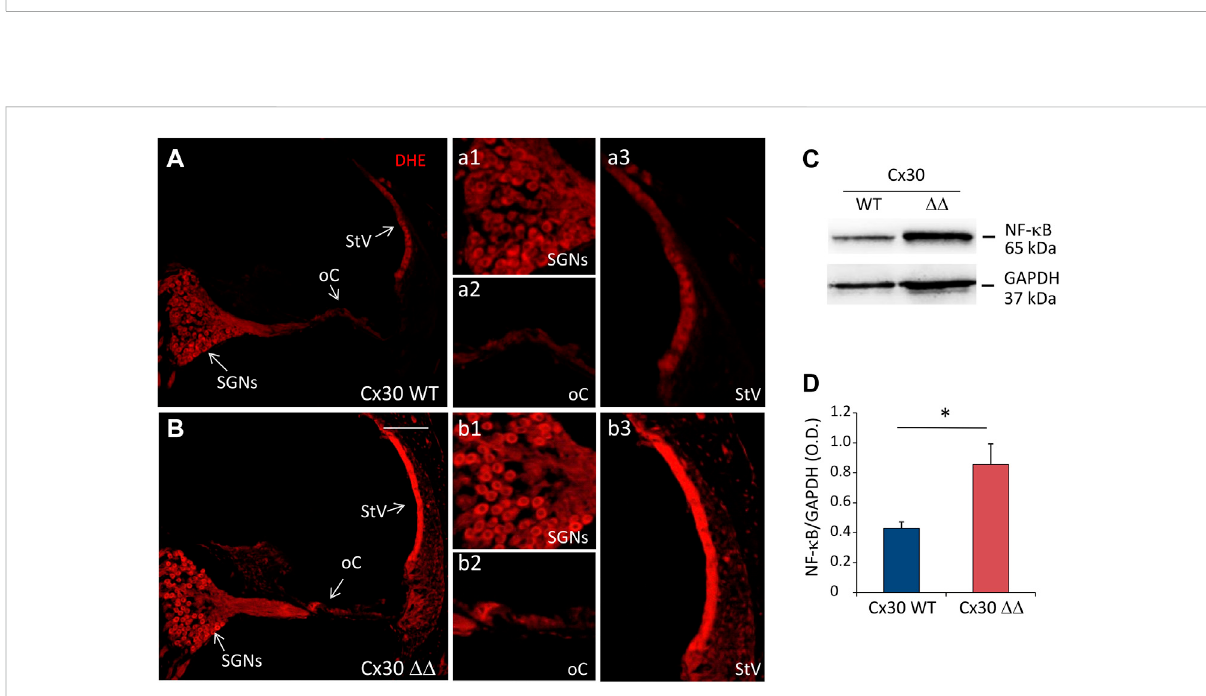
FIGURE 4 Increased oxidative stress and in fl ammation in the cochlea of Cx30 ΔΔ mice of 12 months of age. (A and B) : Representative images of cochlear cryosectionsfromCx30WT (A) andCx30 ΔΔ (B) miceof12monthsofagestainedwithDHEtoanalyzetheROSamount.N=4cochleae/group.High magni fi cations of spiral ganglion neurons (a1 and b1), the organ of Corti (a2 and b2), and stria vascularis (a3 and b3) are shown. (C) : Representative western blot immunoreactive bands quantifying the expression of NF- κ B in cochlear lysates from Cx30 WT and Cx30 ΔΔ animals at 12 months of age. (D) Histograms (mean ± S.E.M.) represent optical density normalized to GAPDH. N = 8 cochleae/group. Asterisks indicate signi fi cant differences between groups from Student ’ s t-test (* p < 0.05). SGNs, spiral ganglion neurons; oC, organ of Corti; StV, stria vascularis.